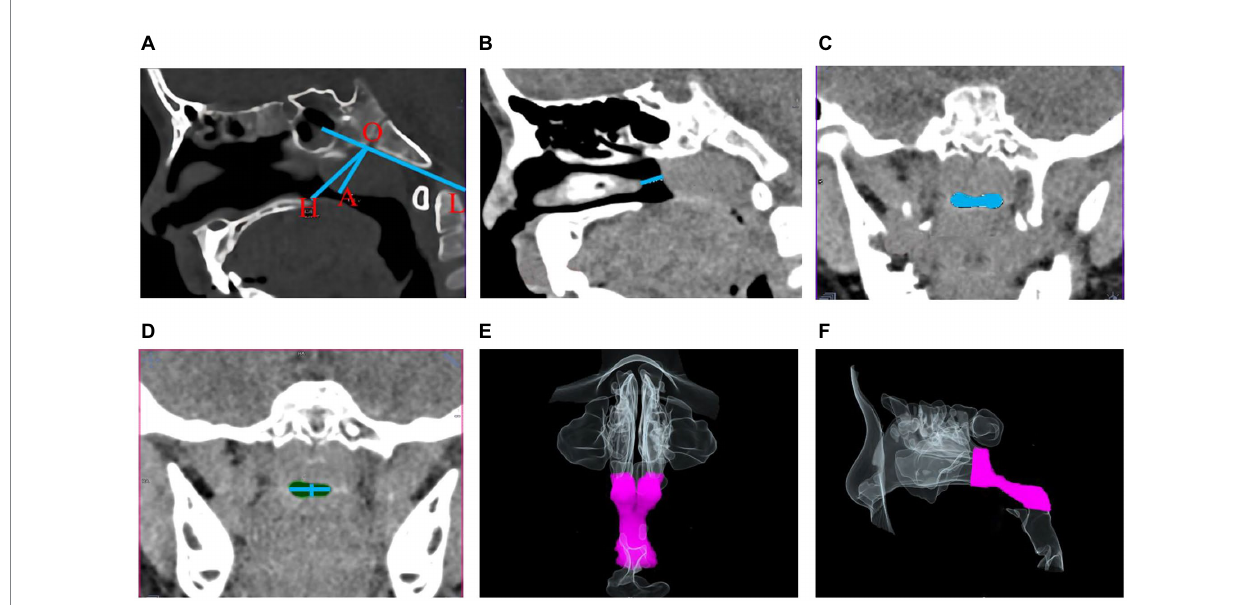
FIGURE 1 Schematic diagram of morphological indicators of the upper airway. (A) Nasopharyngeal cavity width (OH) and adenoids thickness (OA); (B) Right nasal gap size; (C,D) Minimum cross-sectional area of the upper airway in coronal position and its upper-lower, right–left diameters; (E,F) Coronal (E) and sagittal (F) upper airway volume model VR plots.